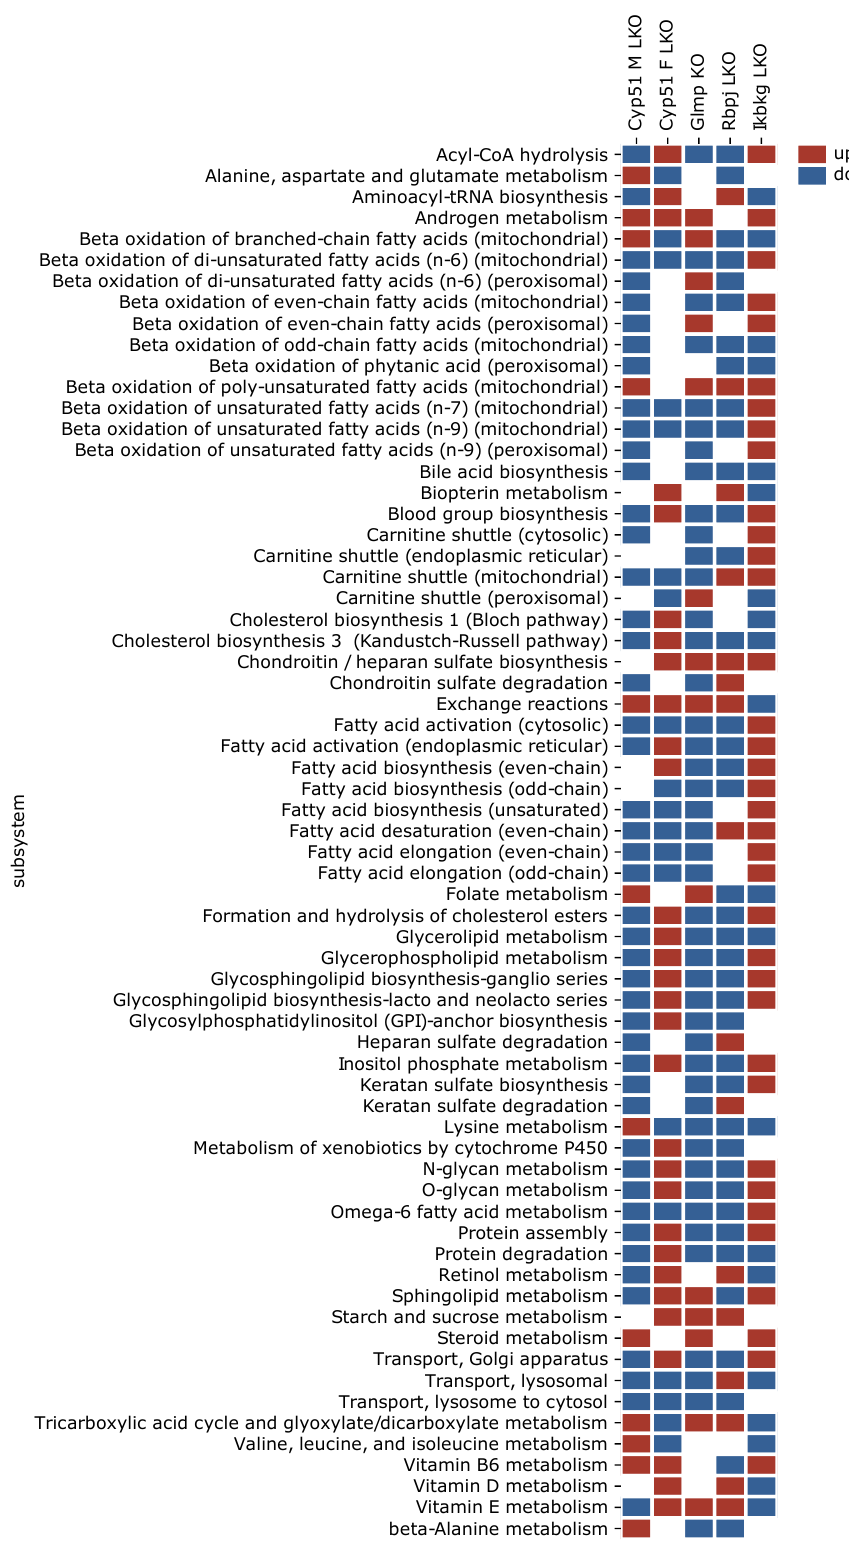
Figure 3. Statistically significantly perturbed genome-scale metabolic model (GEM) subsystems. Presented are subsystems common to at least three models of liver fibrosis. Red is upregulated, blue is